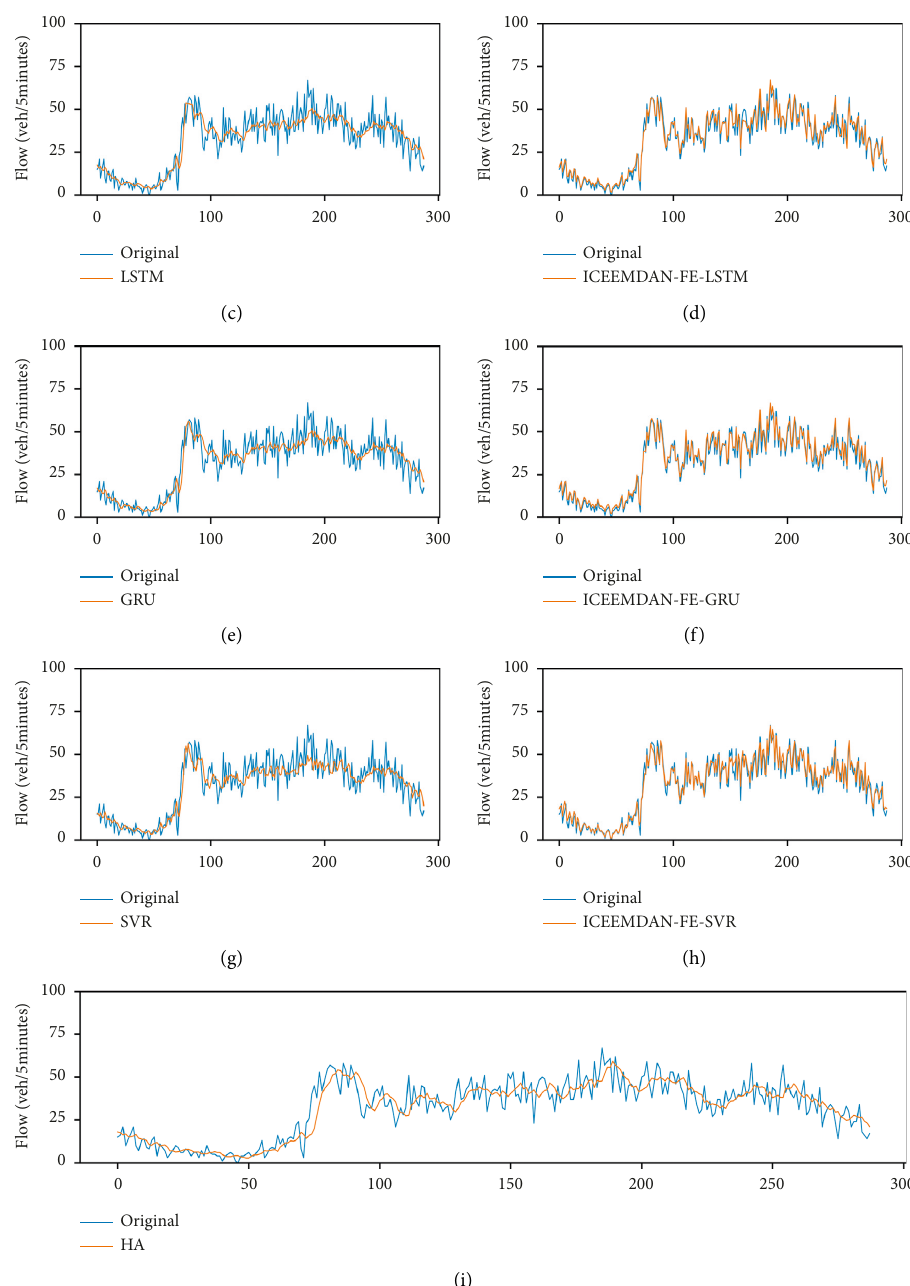
Figure 14: One-step ahead prediction performance comparison on Aug 31, 2018, of different algorithms of